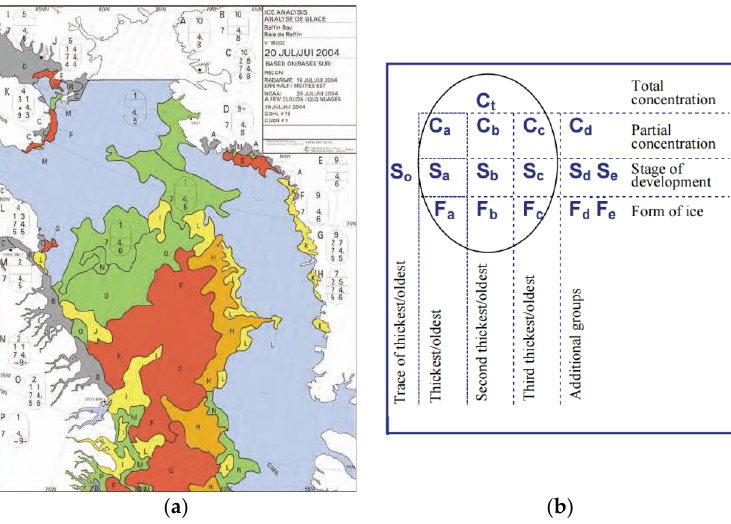
Figure 2. The color-coded daily ice chart example ( a ) and Egg Code ( b ) of ice regime. The colored